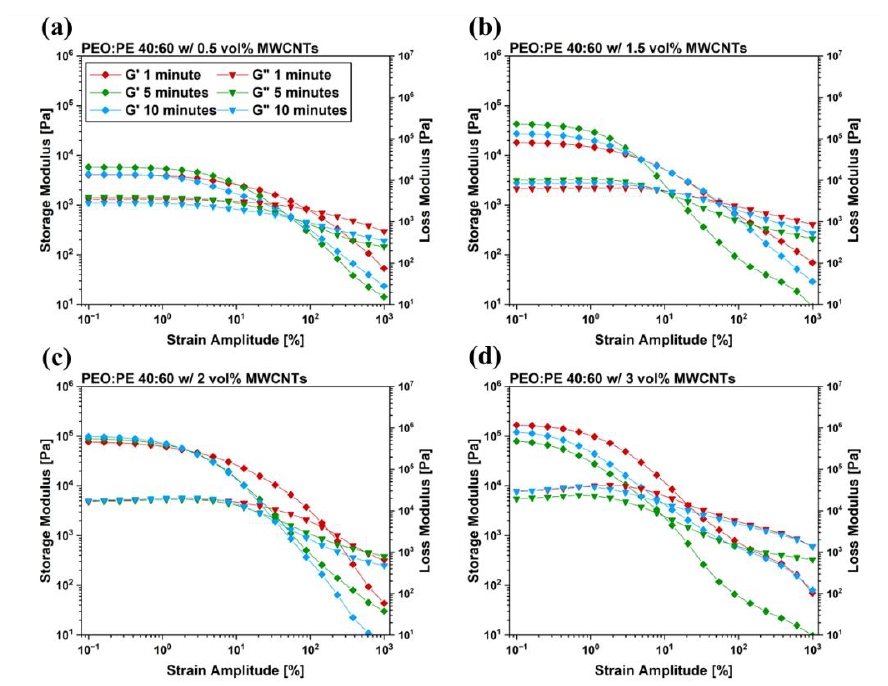
Figure 7. Strain sweep results for PEO/PE 40:60 blends containing MWCNTs at concentrations of ( a ) 0.5 vol%, ( b ) 1.5 vol%, ( c ) 2 vol%, and ( d ) 3 vol%.